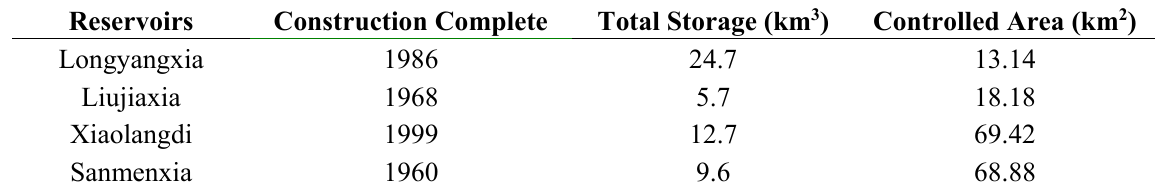
Table 3. Characteristics of large reservoirs in the Yellow River